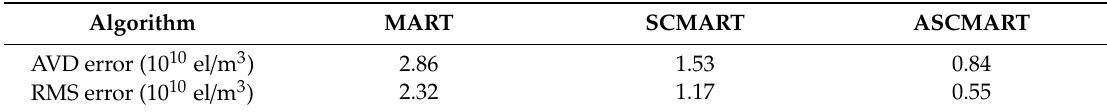
Table 2. Tomographic error statistics of the MART, the SCMART, and the ASCMART during geomagnetic quite day.